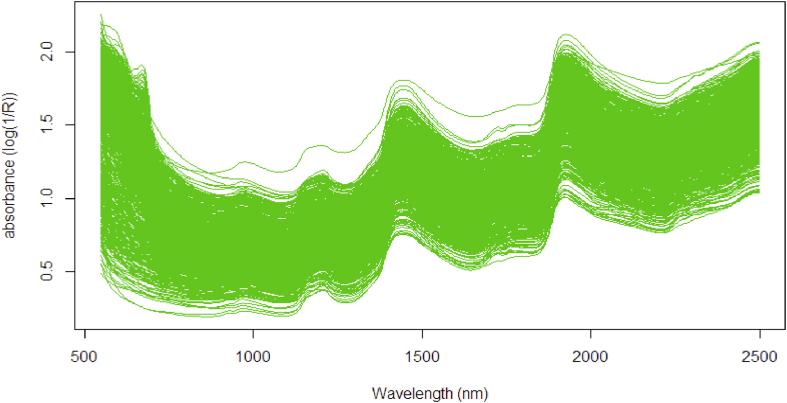
First run of averaged spectra on oil palm fresh fruit mesocarp.